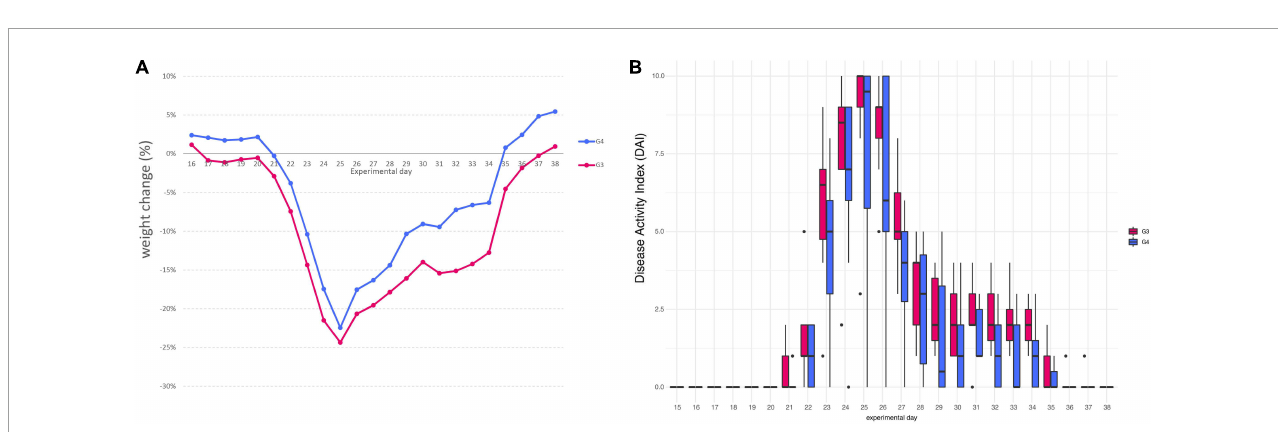
FIGURE3 Variation in the average body weight gain percentage between mice of G3 and G4 (A) . Disease Activity Index (DAI) score of colitis in 1.5% DSS treated mice G3 and G4 (B) .